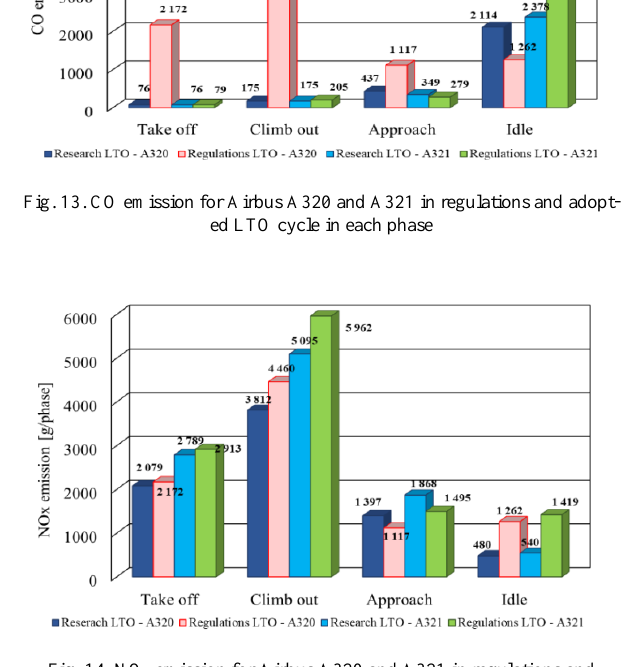
Fig. 14. NO x emission for Airbus A320 and A321 in regulations and adopted LTO cycle in each